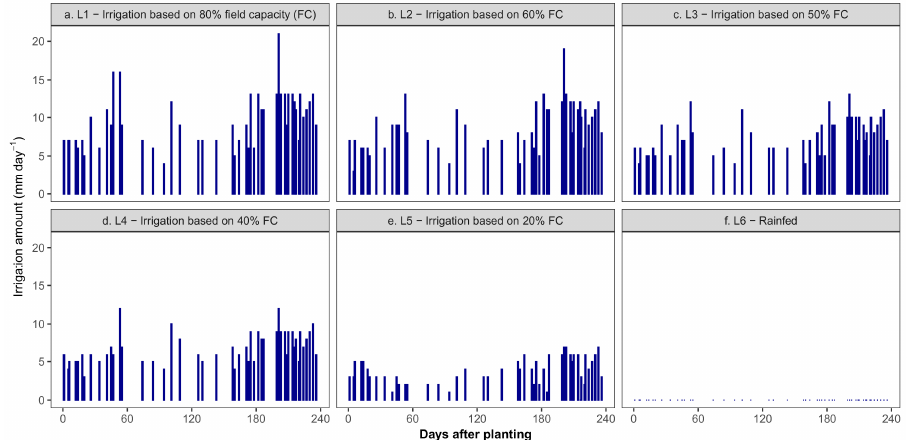
Figure 3. Detailed irrigation schedule for the different treatments during the Guinea grass ( Megathyrsus maximus cv. Agrosavia sabanera) first growing season (from 19 June 2020 to 24 February